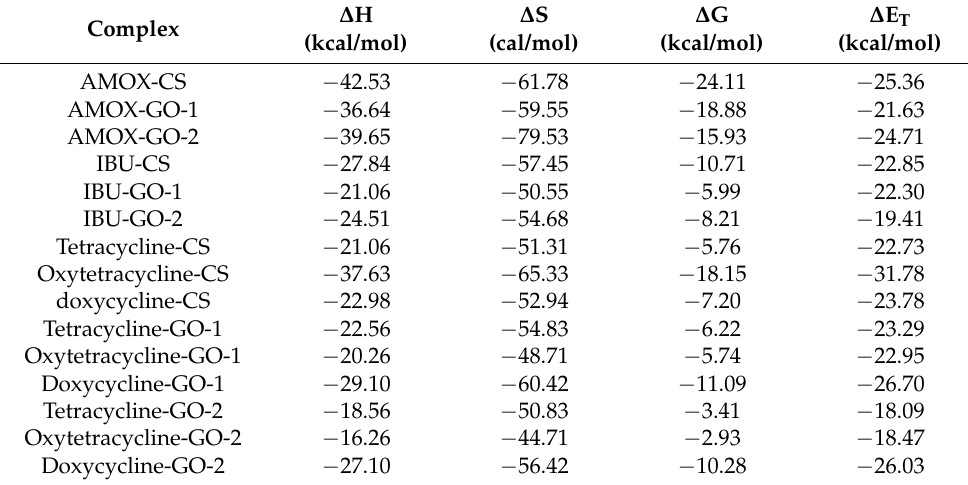
Table 1. Thermodynamic parameters for the complexation of amoxicillin, ibuprofen, tetracycline, oxytetracycline and doxycycline with chitosan and graphene oxides, calculated at 298.15 K and 1 atm, using the ω B97X-D/6-31G++(d,p) theory